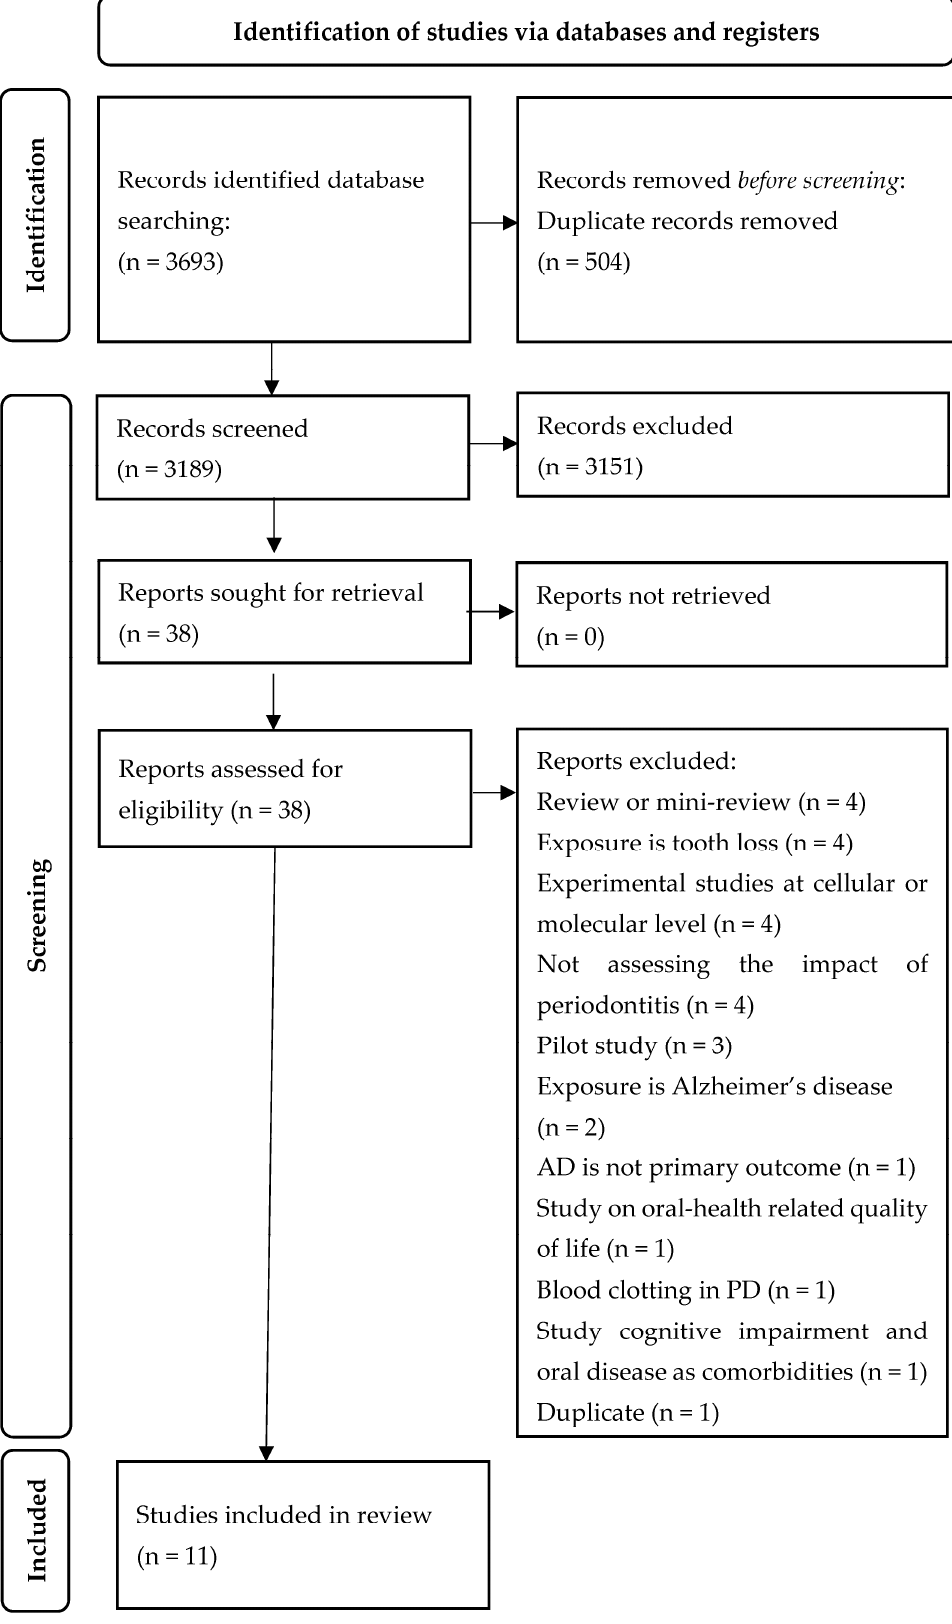
Figure 1. PRISMA flow diagram.